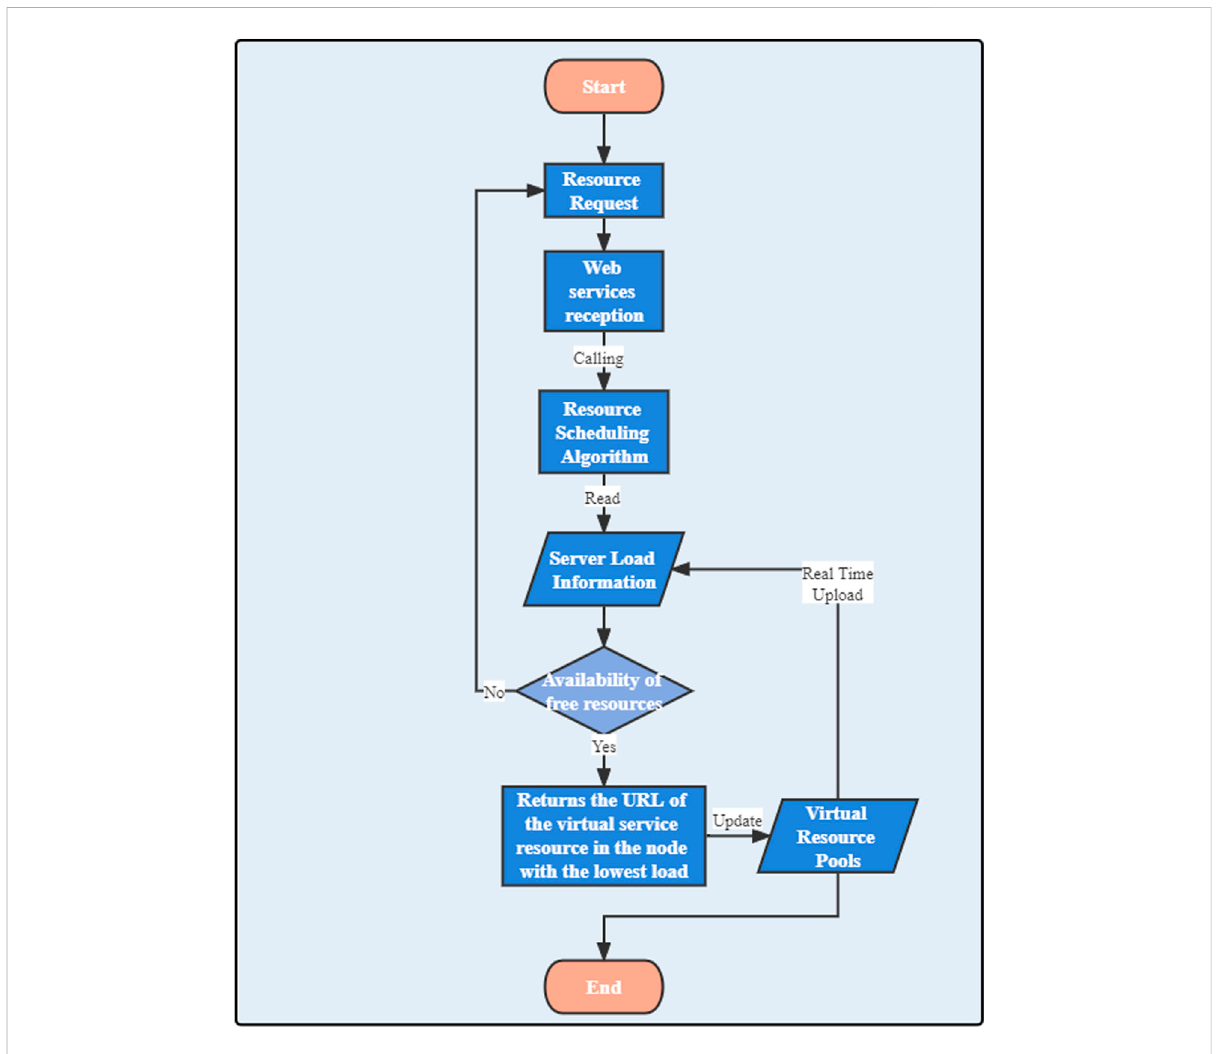
Resource scheduling fl ow